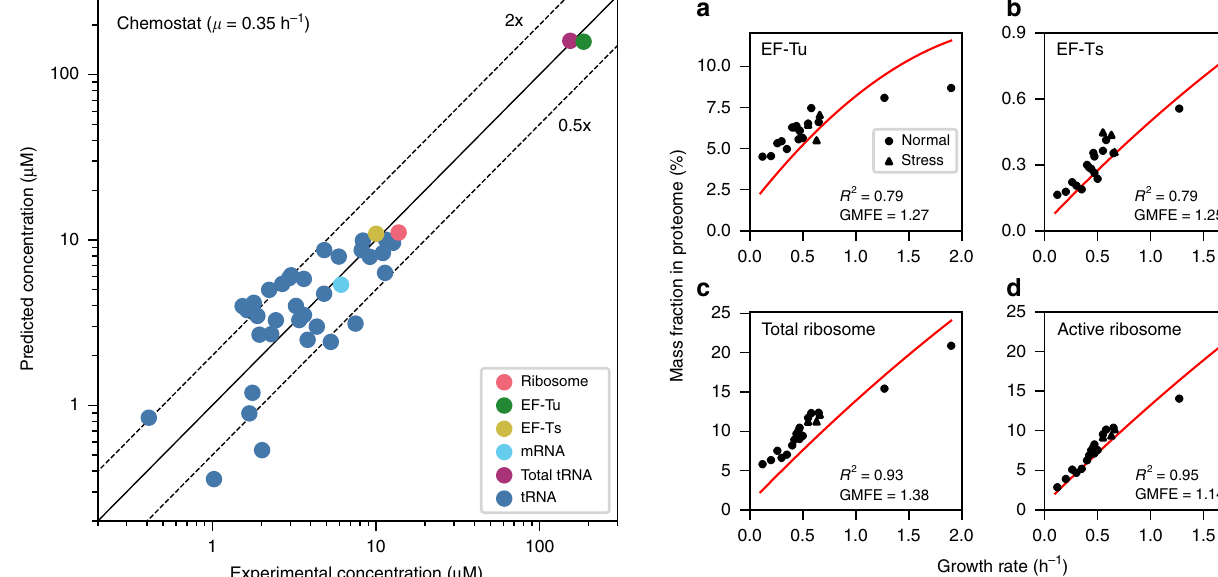
Fig. 2 Predicted vs. observed concentrations in a glucose-limited chemostat. Growth rate μ = 0.35 h − 1 (for other conditions, see Supplementary Fig. 1). The solid line shows the expected identity, whereas the upper and lower dashed lines show prediction errors of 2x and 0.5x, respectively. Predictions for ribosome, EF-Tu, EF-Ts, mRNA, and total tRNA are highly accurate, with Pearson ’ s R 2 = 0.99 and geometric mean fold- error GMFE = 1.13, i.e., predictions based purely on a physico-chemical model and the assumption of cost minimization are on average 13% off. Predictions for individual tRNA species are somewhat less accurate, GMFE = 1.64. Experimentally determined concentrations of the ribosome (averaged over all ribosomal proteins), EF-Tu, and EF-Ts are from ref. 28 . mRNA 30 and tRNA 29 concentrations are interpolated values based on growth rates. Source data are provided as a Source Data fi